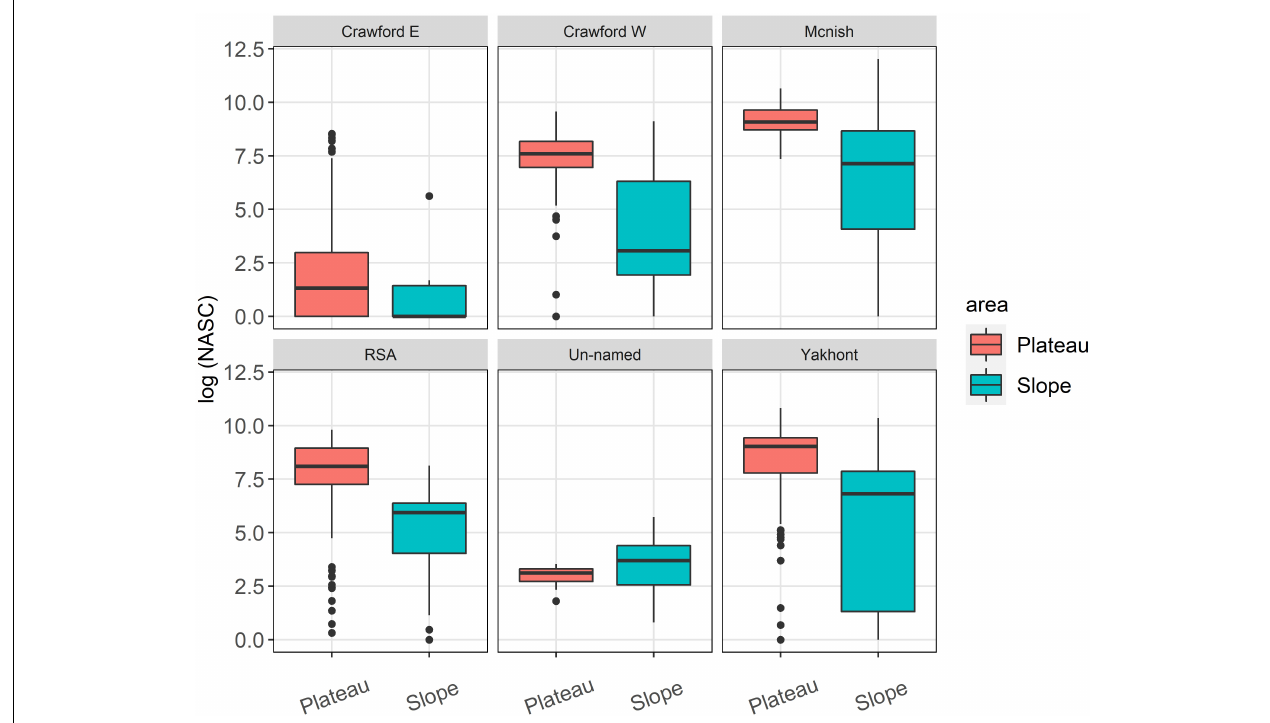
FIGURE 5 | Boxplot of the log-transformed Nautical Area Backscattering Coefficient (NASC) calculated at the plateau and slope for each of the seamounts. Lower and the upper hinges correspond to the first and third quartiles. Dots at the end of the boxplot represent outliers.